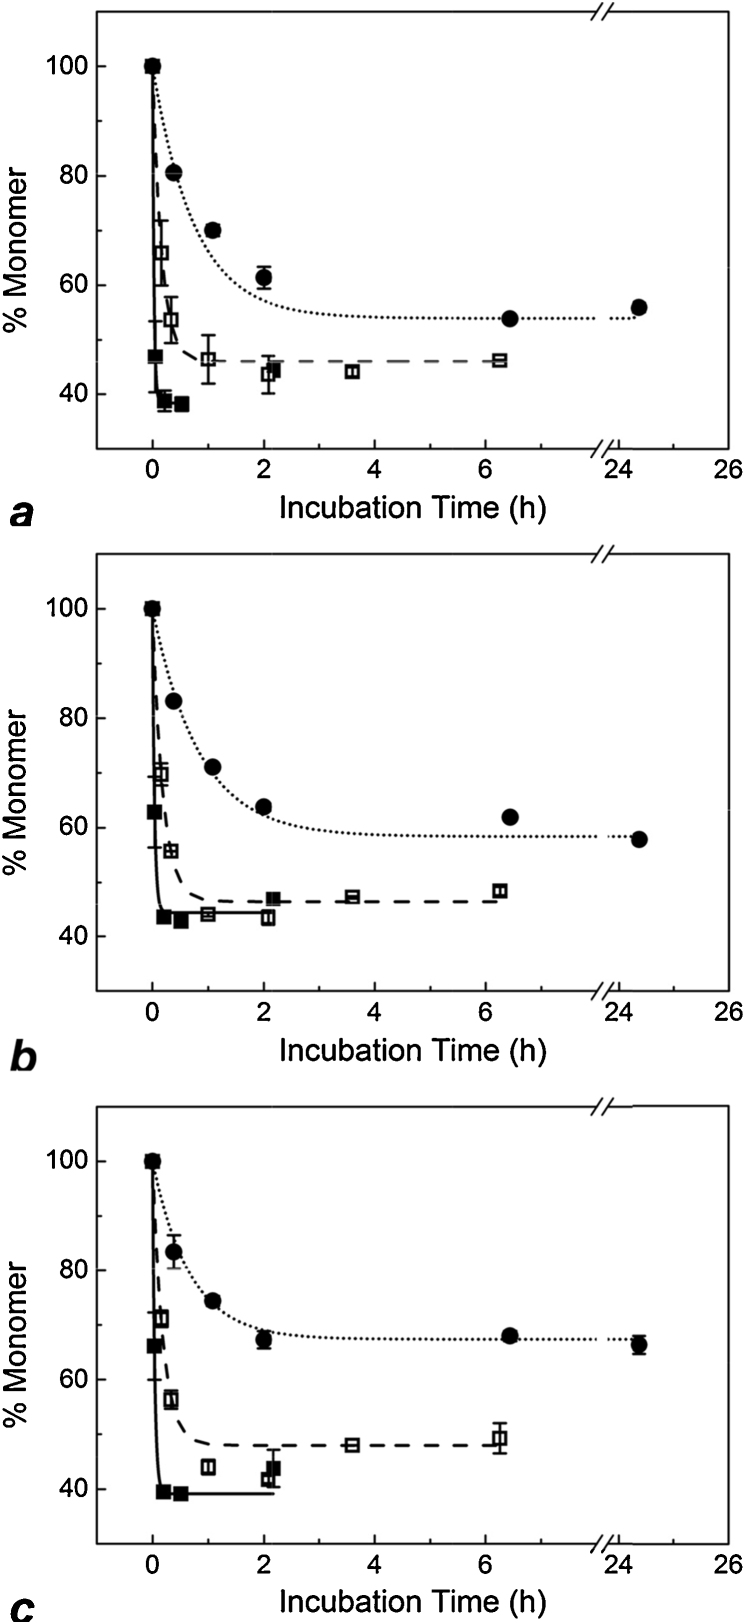
IgG monomer loss over time in solution at (a) 0.9 mg/mL, (b) 2.7 mg/mL and (c) 4.5 mg/mL. Different symbols represent different incubation pH conditions: circles, pH 3.03; open squares, pH 2.95; filled squares, pH 2.78. Error bars show the standard deviation for each point based on full experimental repeats, n = 2. Exponential decay curves were fitted to the data using the equation y = y0 + AeR0.x (see Section 3.2 for equation specifics). In (a), for pH 2.78 the last time point (2.18 h) was excluded from the curve fit (see Section 3.3.1). All fits were significant with adjusted r2 > 0.99 and P < 0.01.